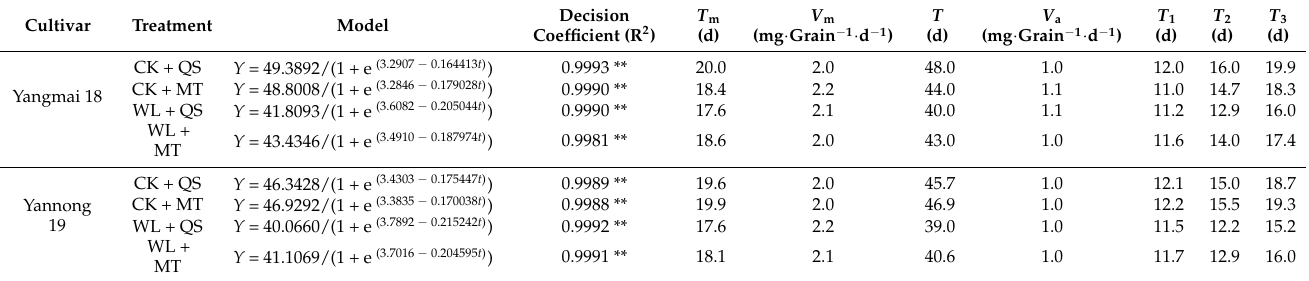
Table 3. Grain-filling parameters under different treatments, i.e., CK + QS: leaf spraying with distilled water under non-waterlogged conditions; CK + MT: leaf spraying with 100 µ mol · L − 1 of melatonin under non-waterlogged conditions; WL + QS: leaf spraying with distilled water under